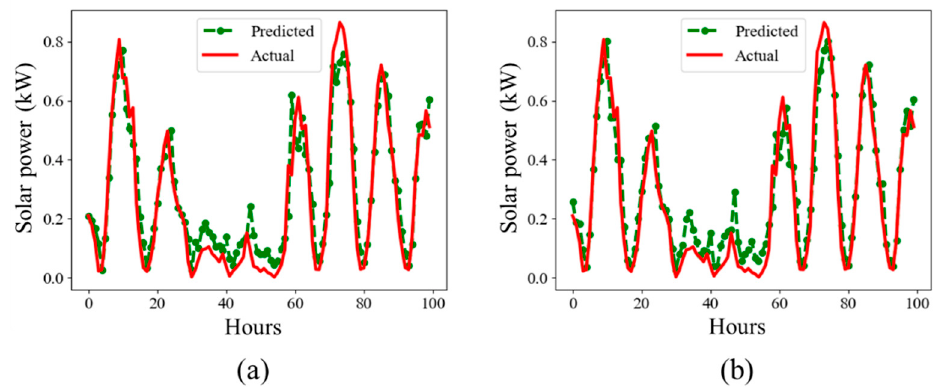
Figure 5. Visual results on hourly solar data, where ( a ) is the BiLSTM prediction graph, while ( b ) is the CNN-BiLSTM prediction graph for solar power in kW.